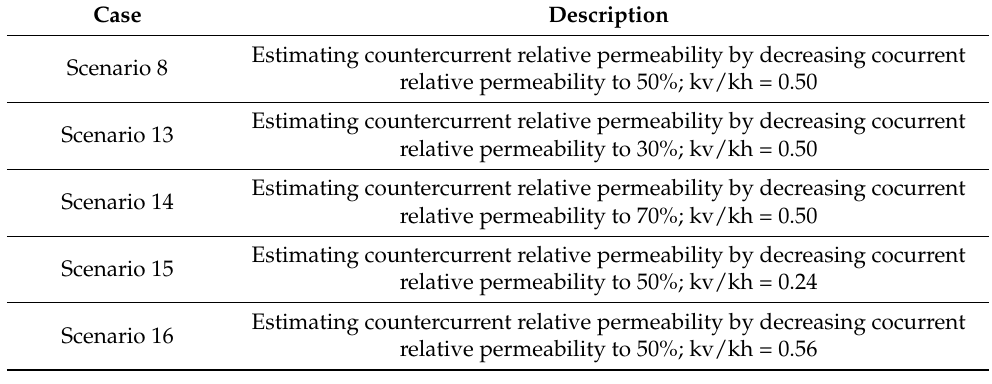
Table 6. Scenarios of modified countercurrent relative permeabilities and kv/kh ratios.